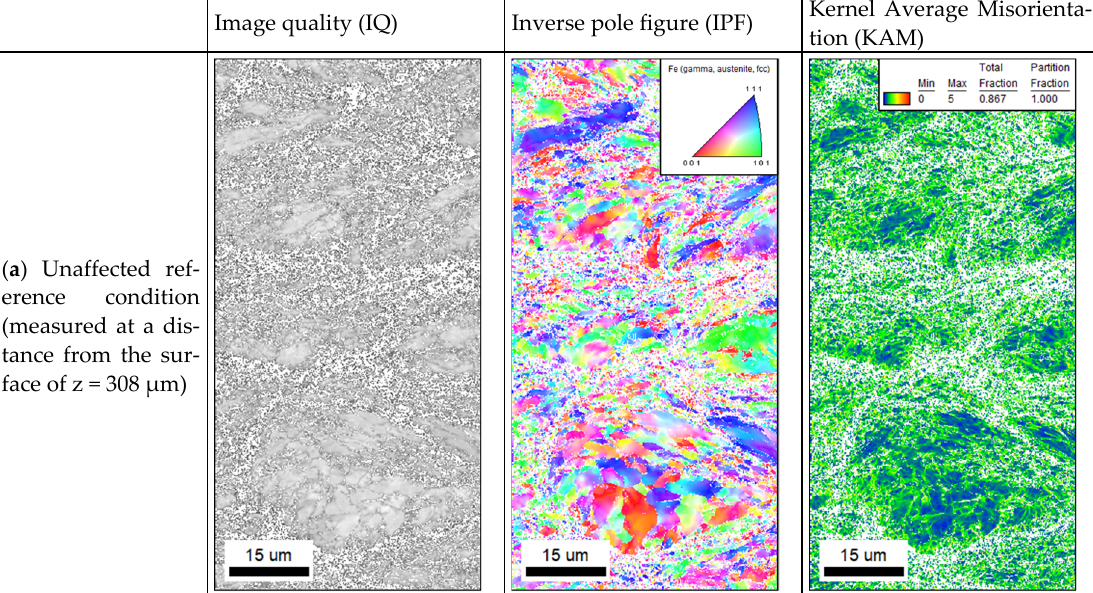
Figure 11. Hardness depth profiles determined (with intermediate milling) for ( a ) 316L (varied deep rolling pressure) and for a constant deep rolling pressure of 200 bar for ( b ) FeTiB and ( c ) FeMnAlC. Inverse pole figure (IPF)